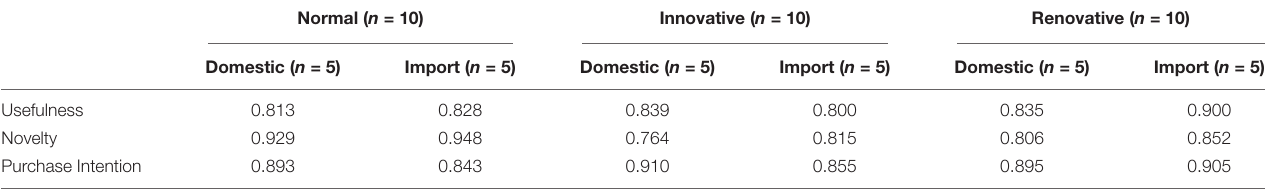
TABLE 4 | In Experiment 2, Cronbach’s α coefficients of usefulness, novelty, and purchase intention variables of three types of domestic and imported products.